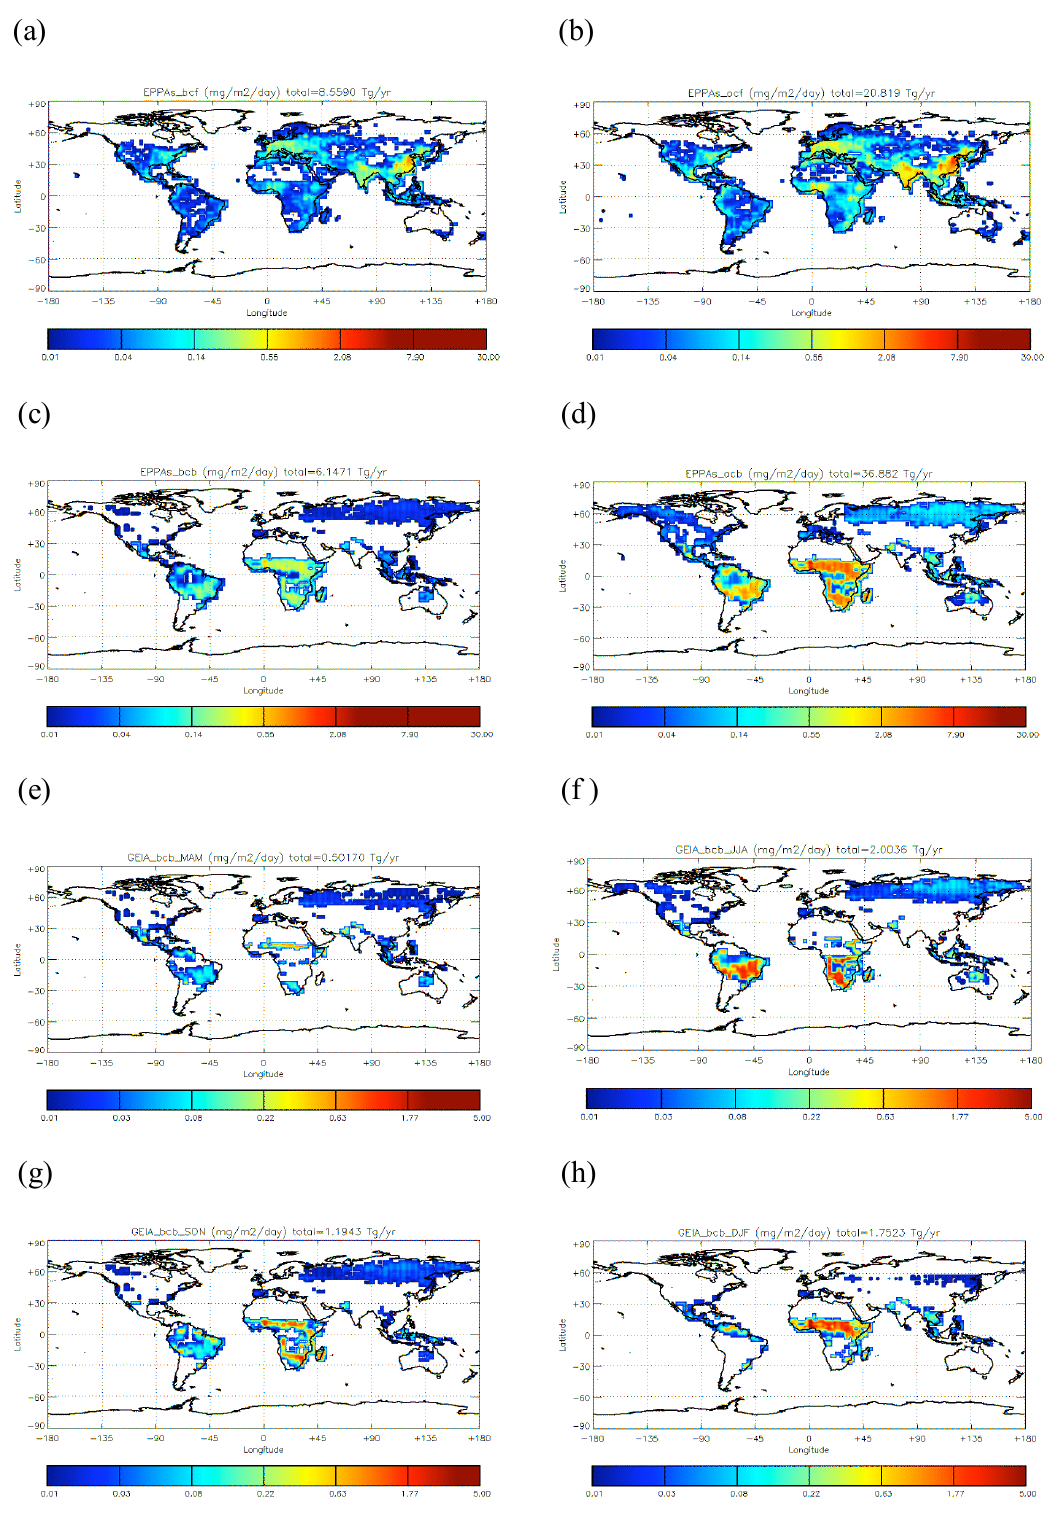
Fig. 1. Global distribution of annual emissions of fossil fuel (a) BC and (b) OC as well as biomass burning (c) BC and (d) OC. Also shown are global distributions of seasonal emissions of biomass burning BC in: (e) March-April-May (MAM), (f) June-July-August (JJA),